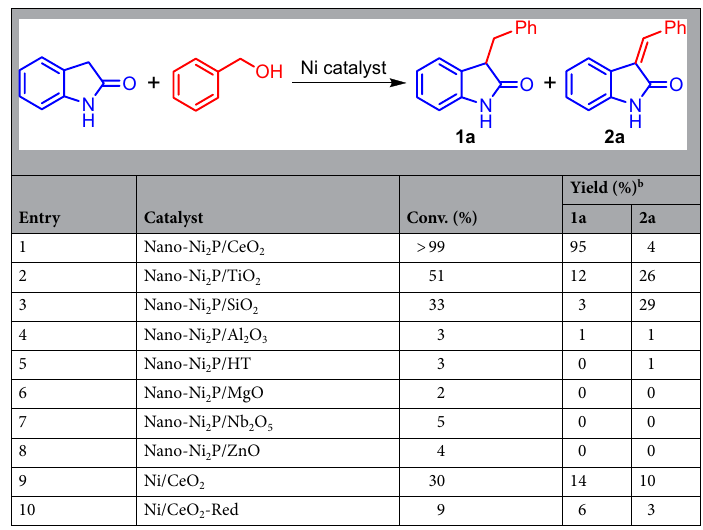
Table 1. C-3 alkylation of oxindole with benzyl alcohol using Ni catalysts a . a Reaction conditions: catalyst (0.15 g, 5 mol% Ni), oxindole (0.5 mmol), benzyl alcohol (1 mmol), toluene (2 mL), 140 °C, 10 h, N 2 atmosphere. b Yields based on oxindole were determined by gas chromatography-mass spectrometry (GC-MS) using naphthalene as an internal